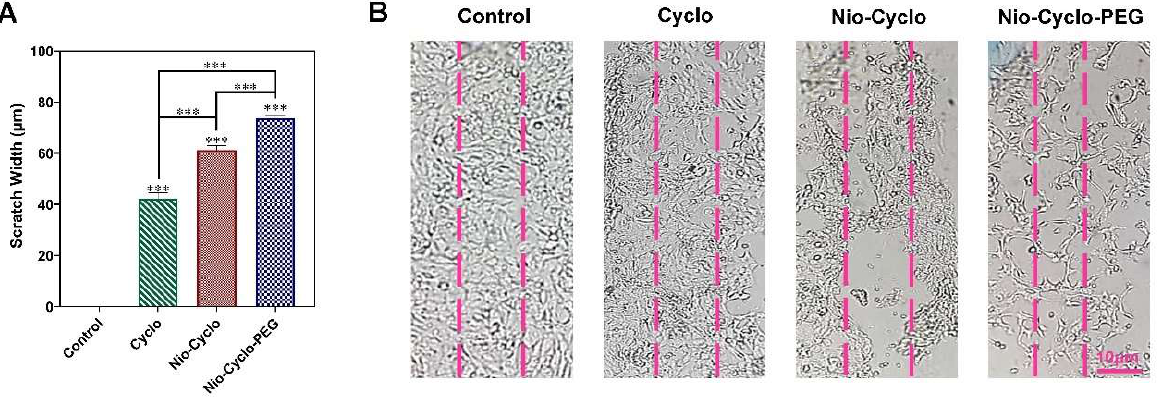
Figure 8. ( A ) The inhibitory effects (scratch widths of samples) of different drug formulations on the migration of the AGS after 72 h of treatment; ( B ) Light microscopy images of AGs cells after treatment for 72 h. The inhibitory effects of different drug formulations, including control (no drug), Cyclo, Nio-Cyclo, and Nio-Cyclo-PEG (from left to right) on migration of the gastric cancer cells; Data are represented as Mean ± SD from three independent experiments ***: p < 0.001).